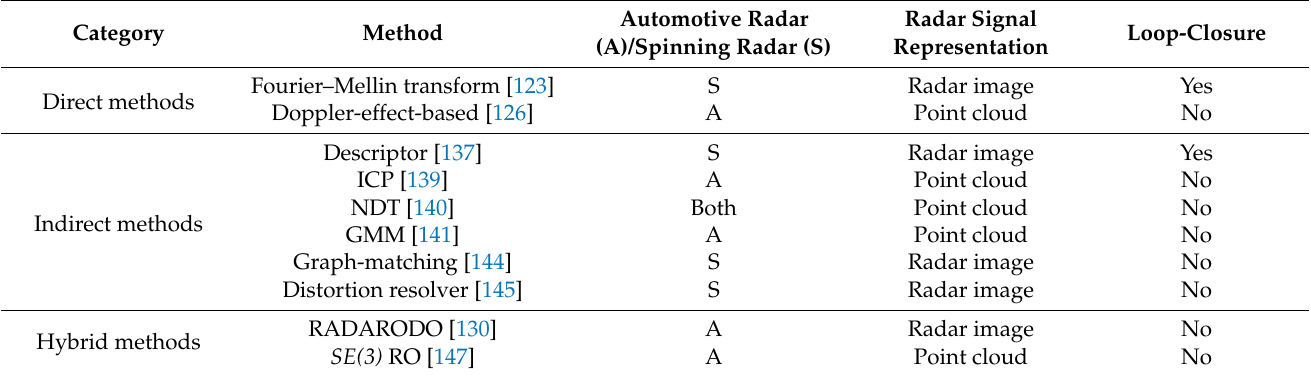
Table 3. Summary of representative radar odometry